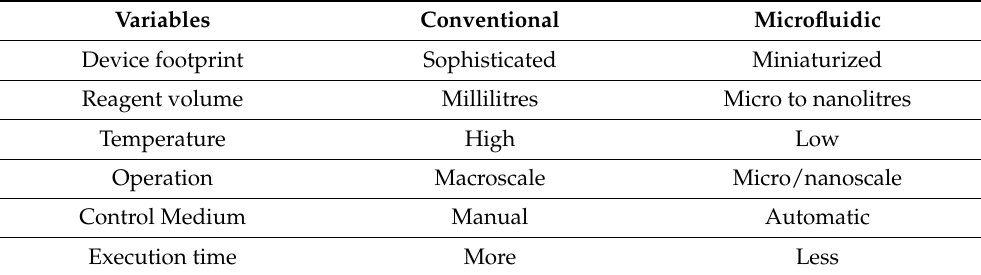
Table 2. Comparison of traditional and microfluidic platforms employed for synthesizing nanomaterials. Variables Conventional Microfluidic Device footprint Sophisticated Miniaturized Reagent volume Millilitres Micro to nanolitres Temperature High Low Operation Macroscale Micro/nanoscale Control Medium Manual Automatic Execution time More